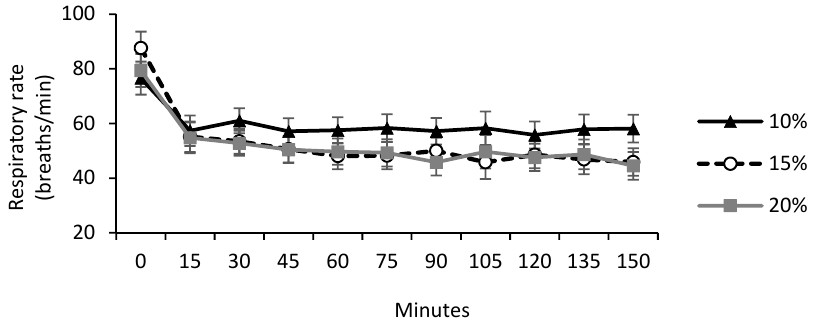
Figure 2. Respiratory rate of newborn dairy calves fed different volume of colostrum, across time effect during a cold challenge; 10% BW as colostrum (n = 10); 15% BW as colostrum (n = 10); 20% BW as colostrum (n = 10). Treatment by time effect interaction ( p = 0.09). Table 1. Rectal and the skin surface temperature, heart and respiratory rates, shivering, and se- lected metabolites and blood hormones during the cold challenge of newborn calves fed different volumes of colostrum.